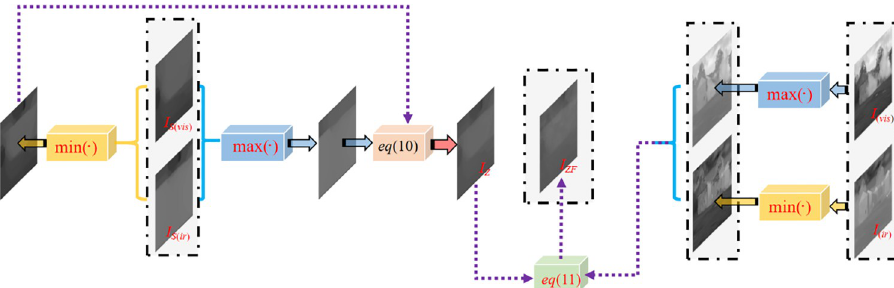
Fig 5. Formulation process of I Z at intermediate frequency